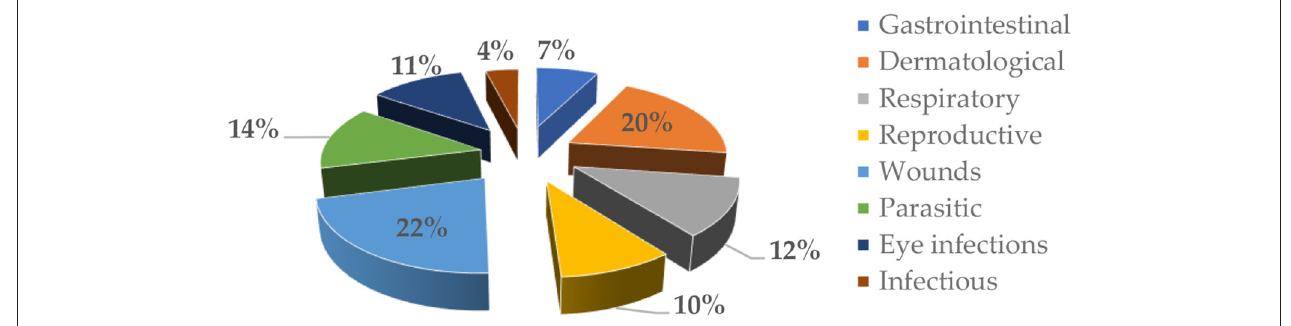
FIGURE 4 | Proportion of veterinary diseases treated with EVM in Omusati and Kunene regions of Namibia (n = 100).